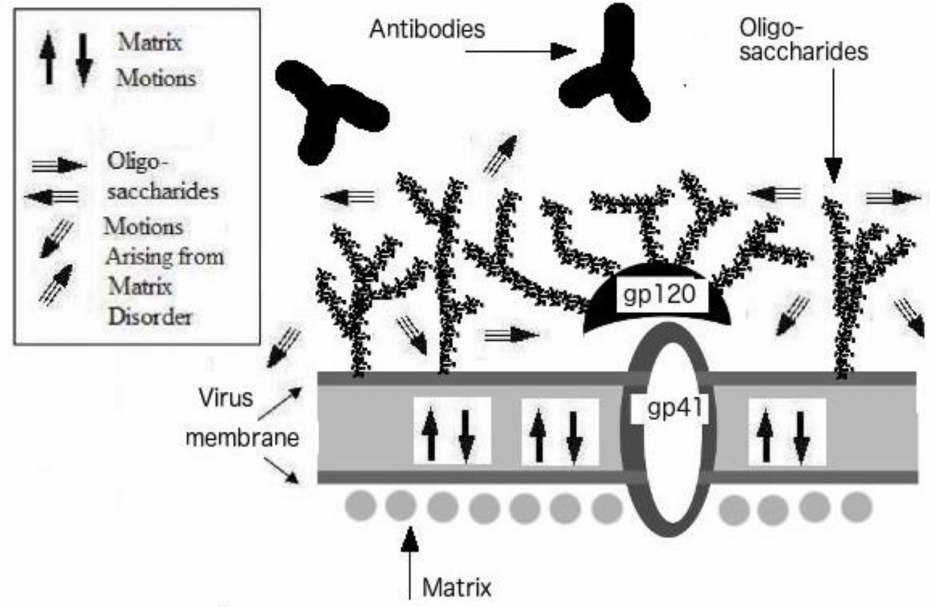
Figure 4. Mechanism of Immune Escape. Figure reproduced with the permission of Gerard KM Goh,